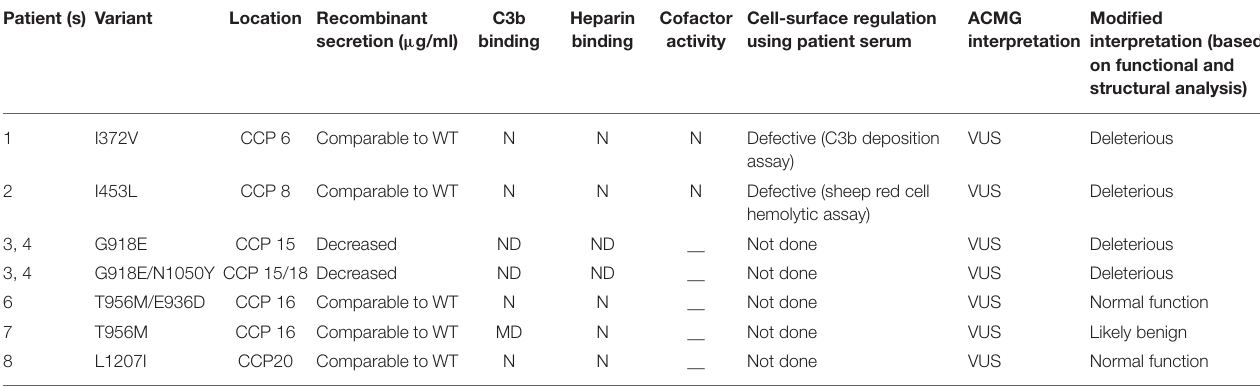
TABLE 2 | Summary of the functional analyses for CFH variants. Patient (s)